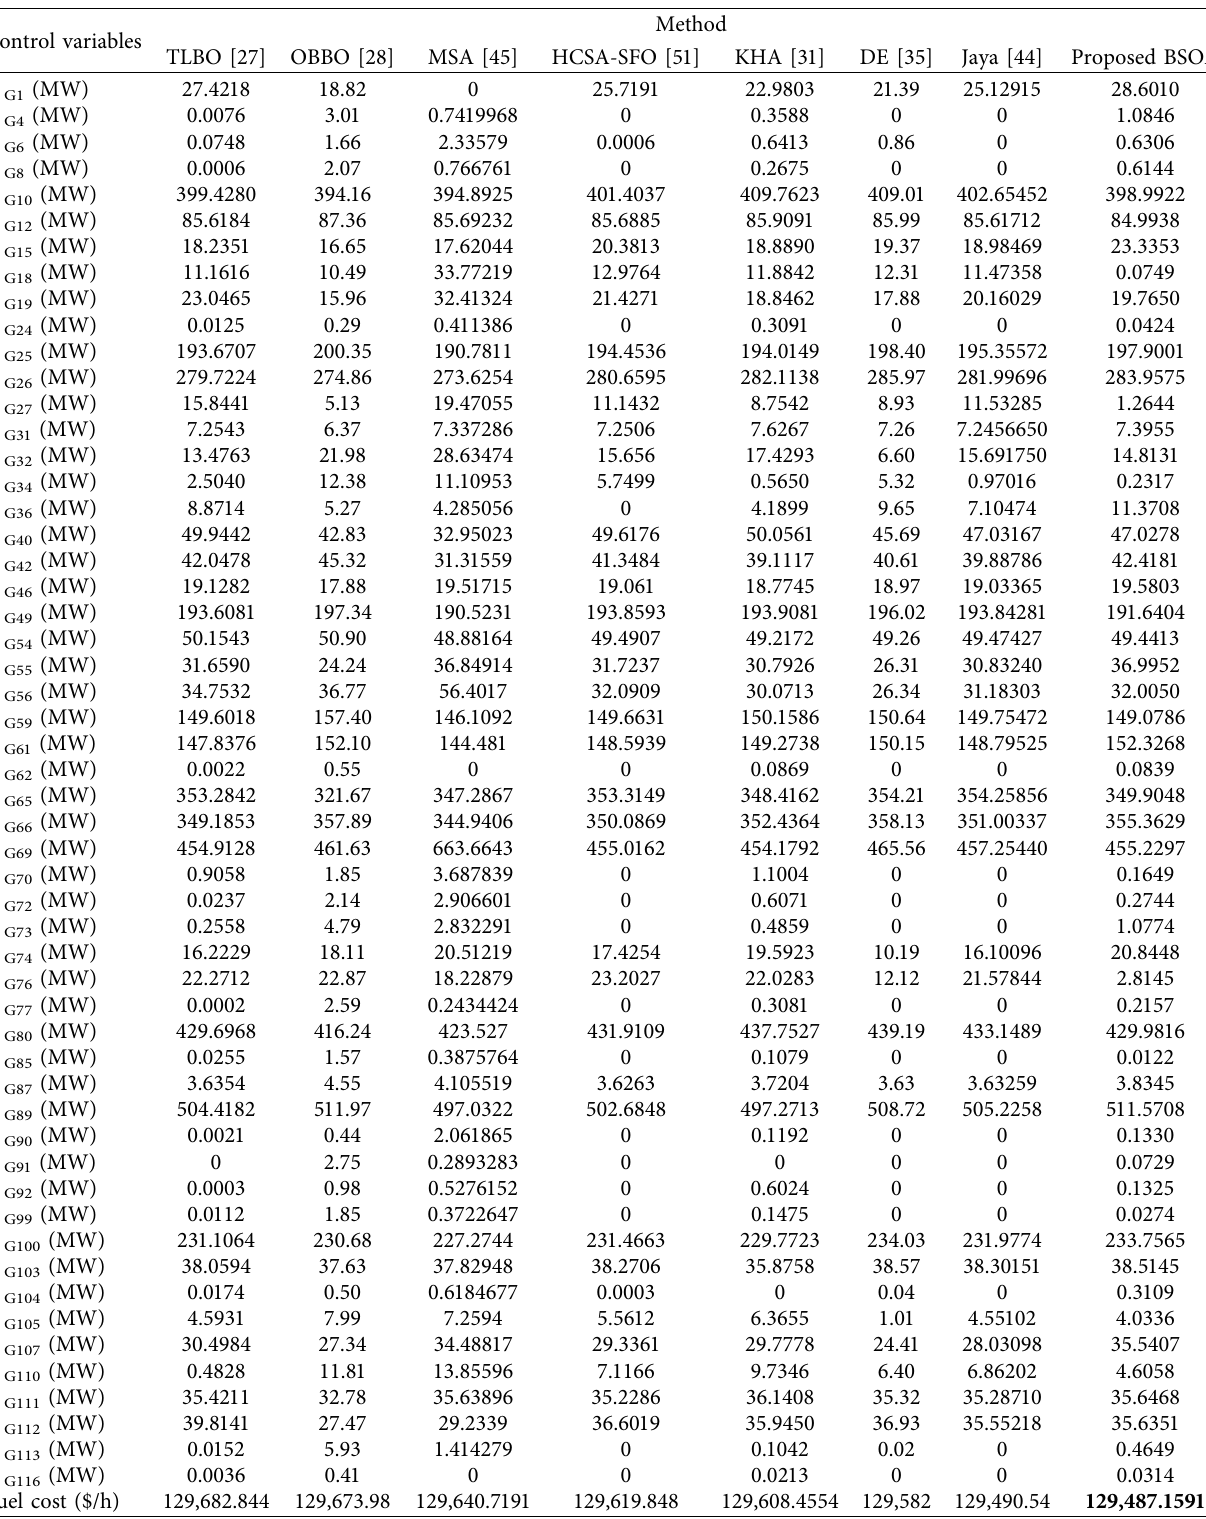
Table 15: Comparison of optimal control variables of generation obtained from diferent recent methods for quadratic fuel cost of the IEEE 118-bus system (Case